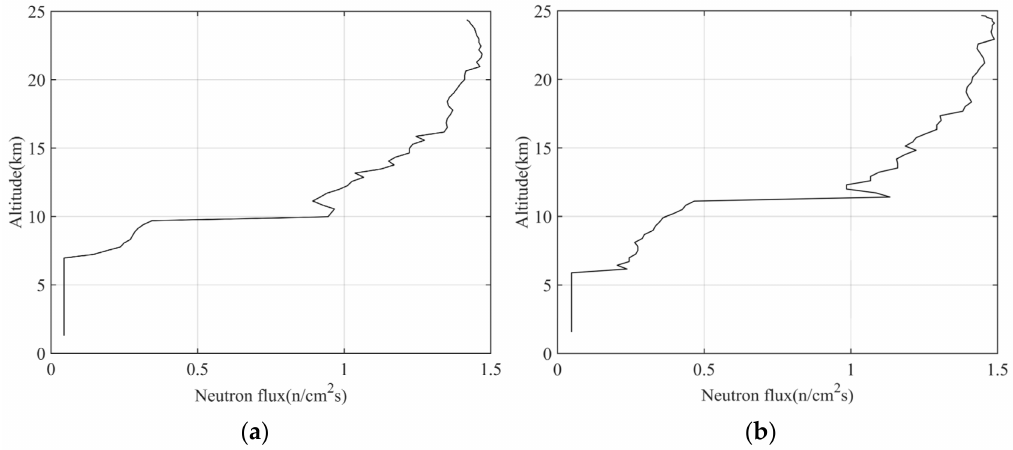
Figure 9. Profiles of the neutron flux (1–10 MeV) varies with altitude on ( a ) Day 1 and ( b ) Day 2,